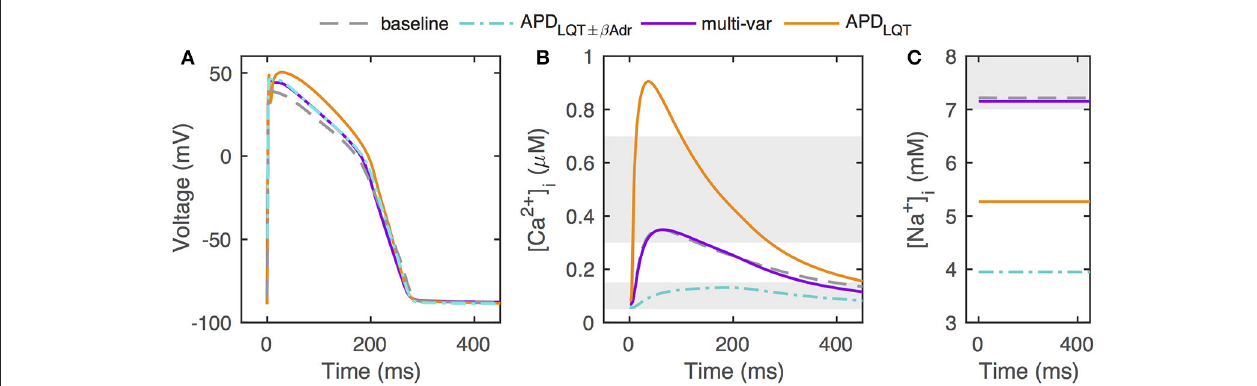
FIGURE 3 | Action potentials, calcium transients, and [Na + ] i in optimized models. (A) Optimized models have similar action potentials under control conditions, but the different parameter sets underlying the different solutions give rise to some waveform variation. (B) Despite having comparable action potentials, models optimized without constraints on [Ca 2 + ] i and [Na + ] i can have widely different calcium transients. Shaded areas give constraints on minimum and maximum [Ca 2 + ] i (0.05–0.15 and 0.3–0.7 µ M, respectively). (C) Without constraints on [Ca 2 + ] i and [Na + ] i , optimization can result in models with very low [Na + ] i levels. Shaded area indicate constraint on [Na + ] i (7–10mM). “APD LQT ± β Adr ” designates the original optimization to clinical LQT data under normal and β -adrenergic stimulation conditions by Mann et al.